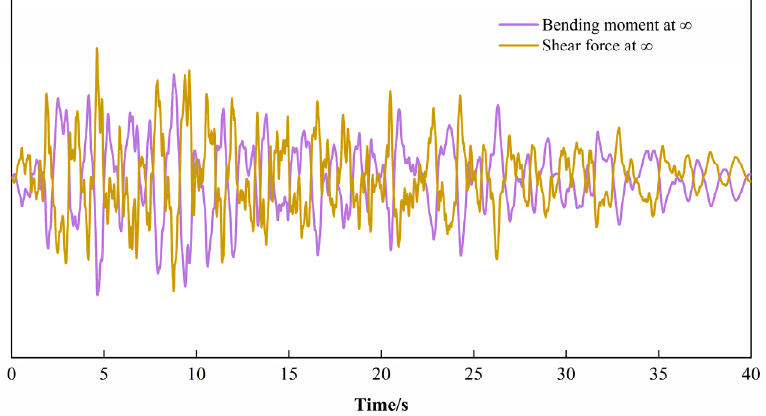
Figure 26. Comparison of time-history curves of internal force at the bottom of 3# main tower under consistent incentives.